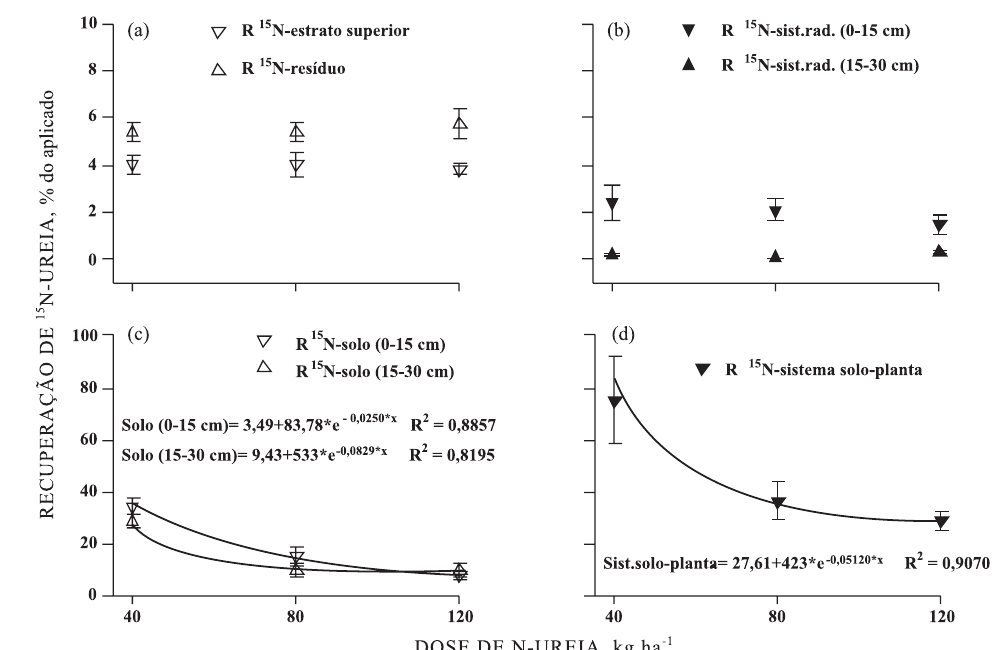
Figura 3. Recuperação de 15 N-ureia (% do N aplicado) nos componentes da pastagem de capim-tanzânia adubada com 40, 80 e 120 kg ha -1 de N-ureia. Os coeficientes das equações apresentadas são significativos (p < 0,05). As barras verticais indicam o erro-padrão da